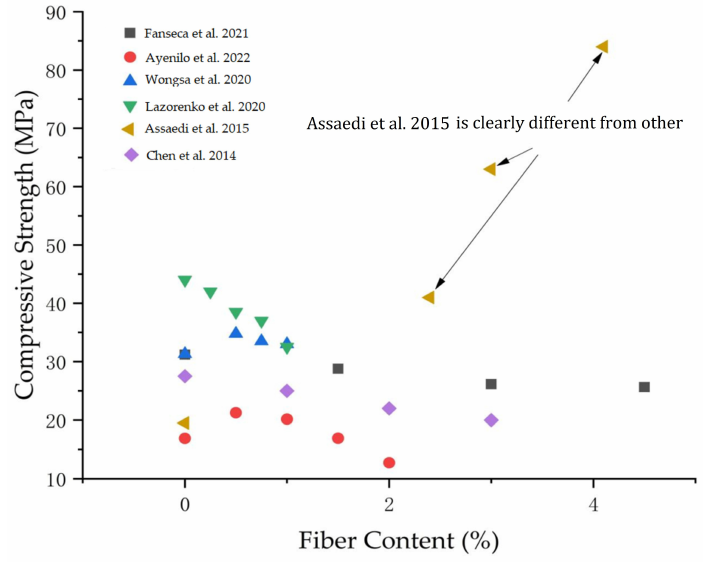
Figure 6. Relationship between fibers content and compressive strength of composites